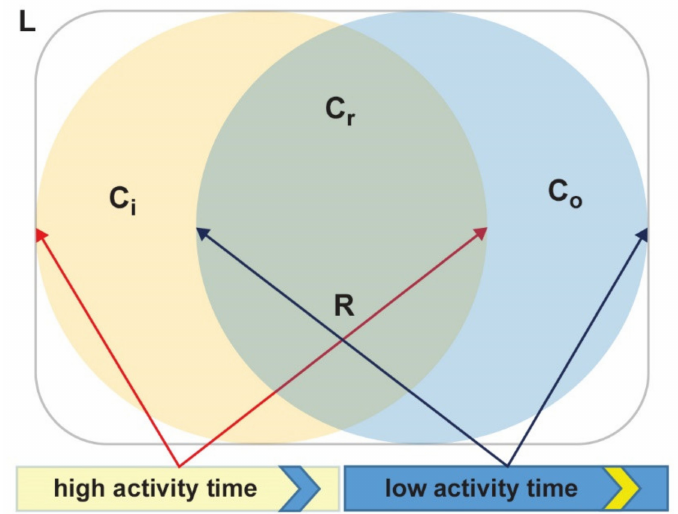
Figure 4. Within-day evolution of people staying in the same place L. Individuals staying inside the overlapping area during the whole day are commuting within the municipality (C r ) and noncommuters (R): C r + R. During the high activity time (yellow circle), incoming commuters (C i ) stay with R and C r , while during low activity time (blue circle), outgoing commuters (C o ) come back and incoming commuters (C i ) go away and individuals inside the municipality are: C r + R + C o